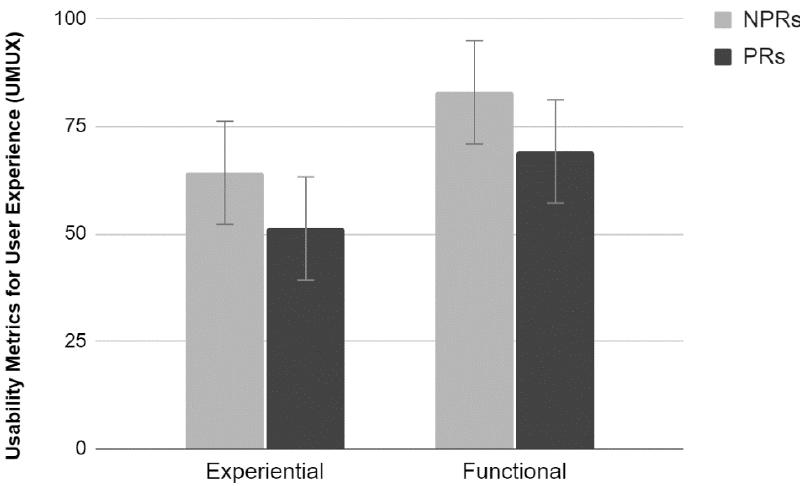
Figure 4. UMUX scale score by Experience (NPRs vs. PRs) and Test (Experiential vs. Functional). Error bars denote 0.95 confidence intervals.